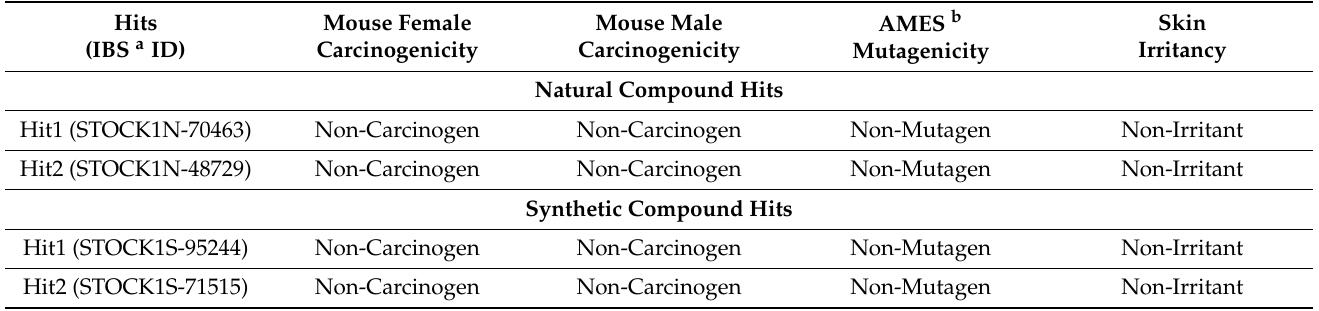
Table 5. Toxicity properties of identified natural and synthetic compound hits generated by TOPKAT